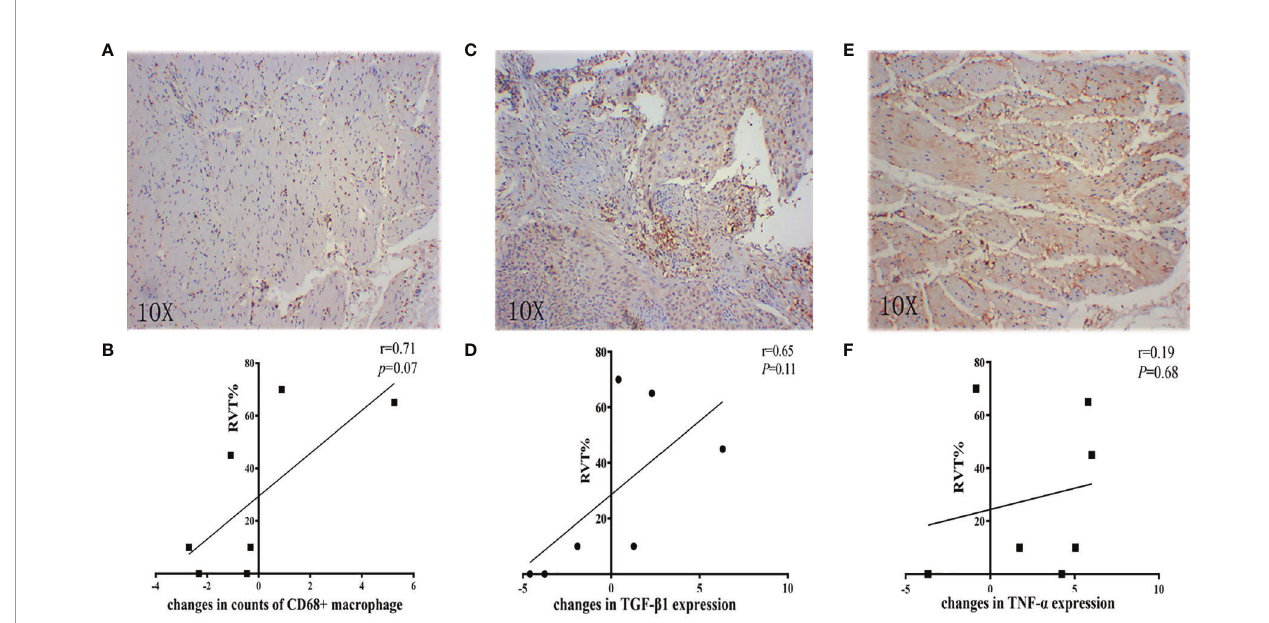
FIGURE 6 | Correlation between in fl ammatory parameters and RVT. (A, C, E) Representative IHC image of CD68, TGF- b 1, and TNF- a ; (B) correlation analysis between changes in counts of CD68 + macrophage and RVT; (D) correlation analysis between changes in TGF- b 1 expression and RVT; (F) correlation analysis between changes in TNF- a expression and RVT. RVT, residual viable tumor; IHC, immunohistochemistry; TGF- b 1, transforming growth factor-beta 1; TNF- a , tumor necrosis